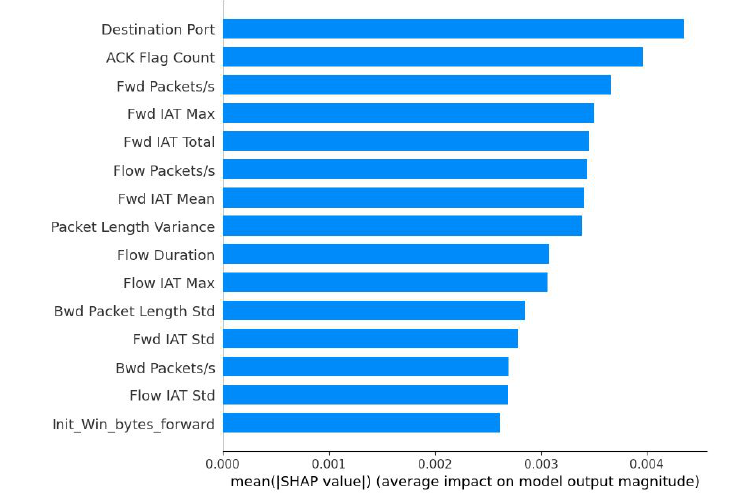
Figure 7. Bar graph of SHAP values calculated for the CIC-IDS2017 dataset using the EIF model of the MemAE-EIF